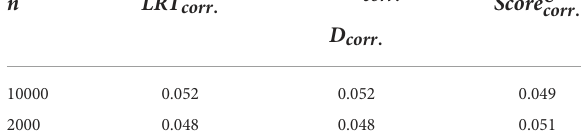
TABLE 6 Type I error rates when using R 2 , ˆ S 2 corrected (or ˜ S 2 ¯ S 2 ¯ F -distribution for calculating the p corrected , corrected ) and the